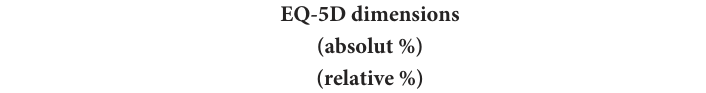
TABLE 6 Health concentration index based on overall self-assessed health measured on the EQ VAS as explained by 5 dimensions of the EQ-5D-3L descriptive system.